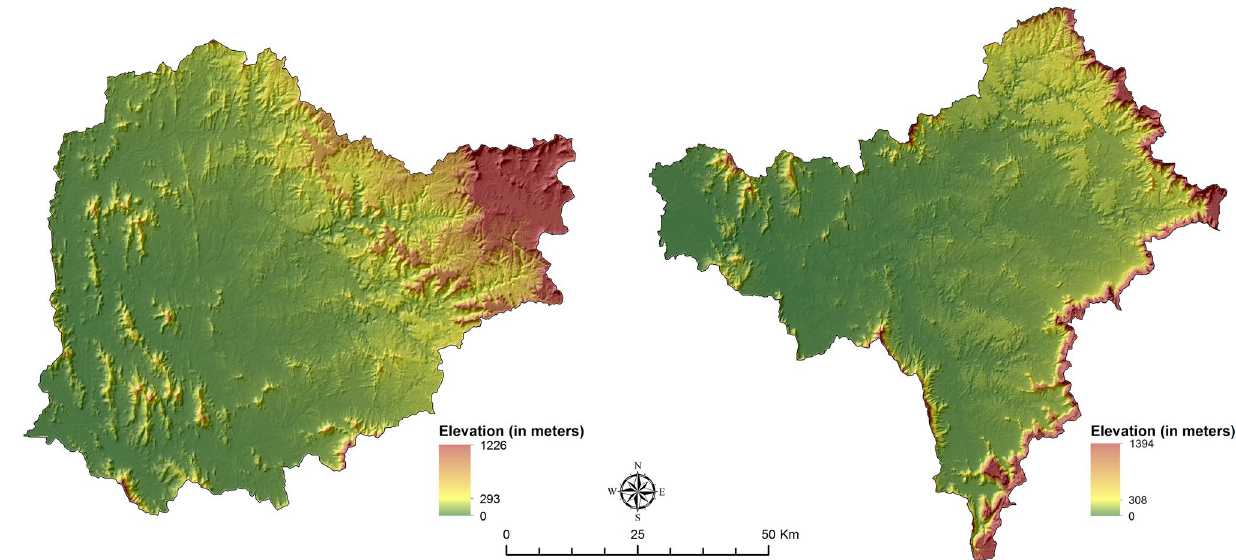
Fig. 6 DEMs are showing a variation of elevation in Vaitarna and Ulhas basin